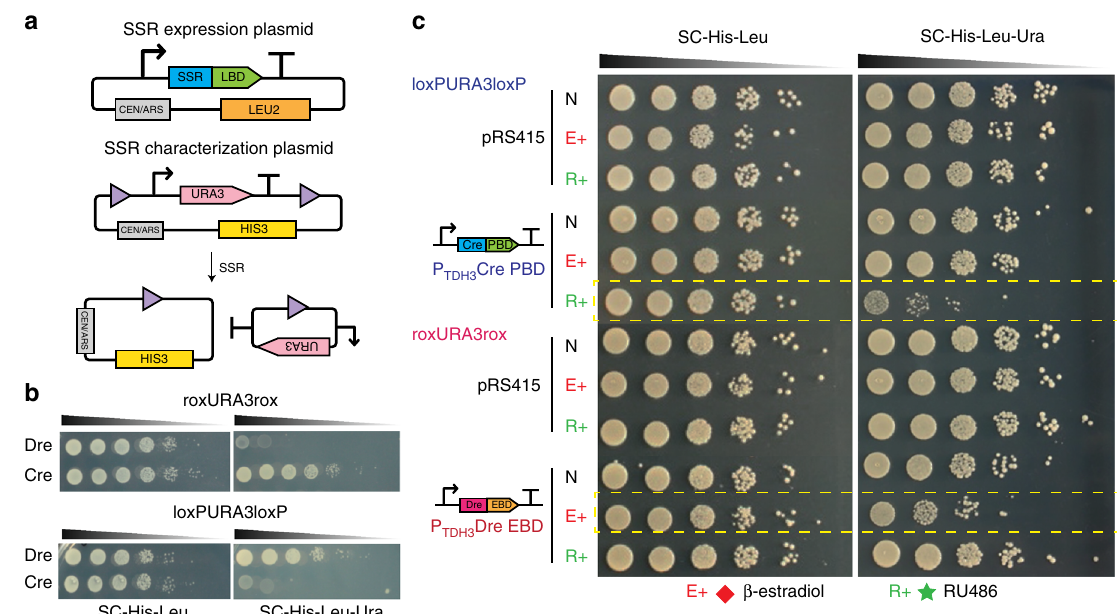
Fig. 6 Orthogonal inducible SCRaMbLE systems. a Design of SSR expression device and functional test device. SSR or SSR-LBD fusion protein were assembled into a pRS415-based centromeric vector with LEU2 as selection marker. URA3 marker was used as recombination reporter and fl anked by two recombination sites. The reporter device was based on pRS413 centromeric vector with HIS3 as selection marker. b Orthogonal function test of Cre and Dre. Yeast cells with reporter device rox- URA3 -rox did not survive with the expression of Dre and cells with reporter device loxP- URA3 -loxP could not survive with the expression of Cre on SC-His-Leu-Ura plate. c Orthogonal induction test of CrePBD and DreEBD. Only cells with reporter device loxP- URA3 - loxP and CrePBD under the induction of RU486, cells with reporter device rox- URA3 -rox and Dre-EBD under the induction of β -estradiol did not survive on SC-His-Leu-Ura plate. PBD progesterone-binding domain, EBD estrogen-binding domain, E + β -estradiol induction, R + RU486 induction, SSR site-speci fi c recombinase, LBD ligand-binding